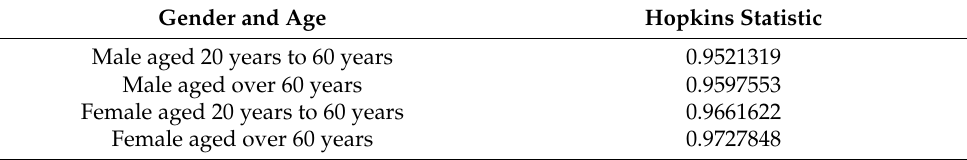
Table 4. Hopkins Statistics Results.